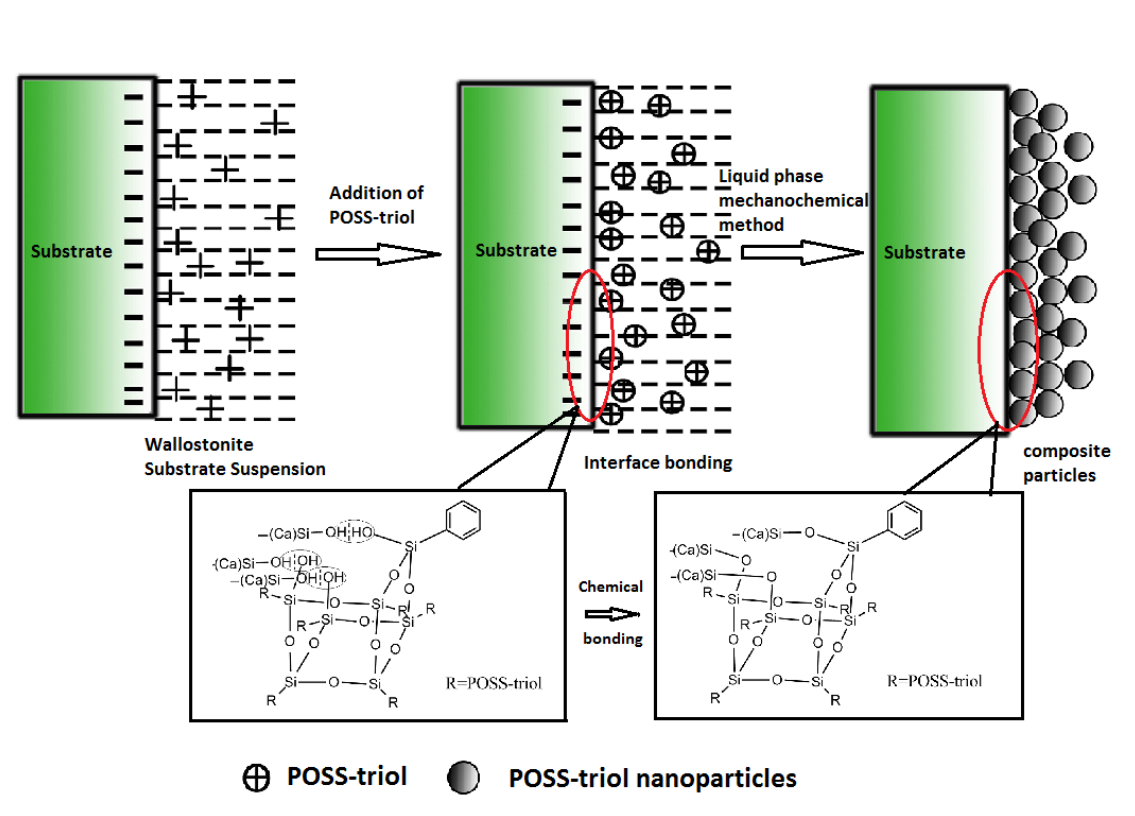
Figure 3: Synthesis of POSS-triol/ wollastonite composite